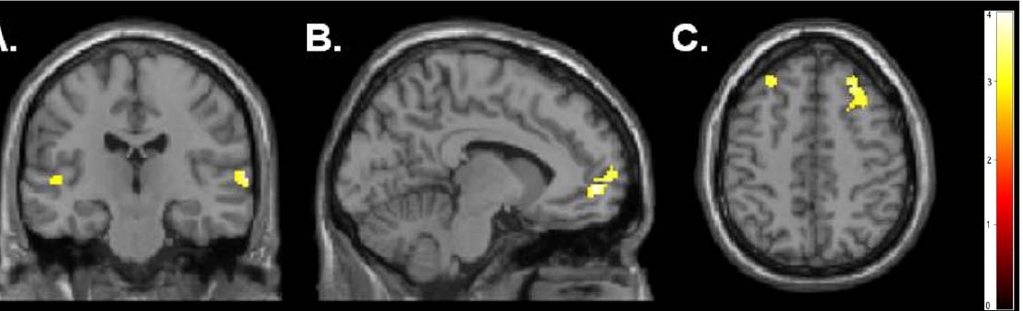
Figure 1. Regions of Interest showing greater deactivation for control participants compared to participants with ASD for the contrast of rest blocks . all tasks combined (language, self-referential langauge, and ToM) in the (A) bilateral STG (68, 2 22, 4; 2 52, 2 62, 26), (B) LMPFC ( 2 2, 66, 10), and (C) bilateral DLPFC ( 2 42, 40, 18; 28, 30, 48) (p , 0.005, cluster-corrected at 110 voxels). doi:10.1371/journal.pone.0050064.g001 PLOS ONE |